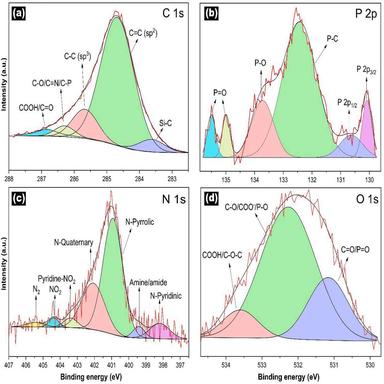
High-resolution XPS spectra of NP-CNTSs. (a) C1s, (b) P2p, (c) N1s, and (d) O1s. The deconvolution analysis shows different functionalities under each spectrum. The binding energy and fitting parameters can be seen in Tables S(4–7). The deconvoluted C1s peak revealed the C– –C (sp2 ) hybridization and C–C (sp3 ) hybridization, the Fe–C bonds, the C–O/C– –N/C–P bonds, and the carboxylic groups (COOH). The P2p spectrum shows P– –O bonds and P–O bonds attributed to phosphate groups. The N1s peak displays diffe